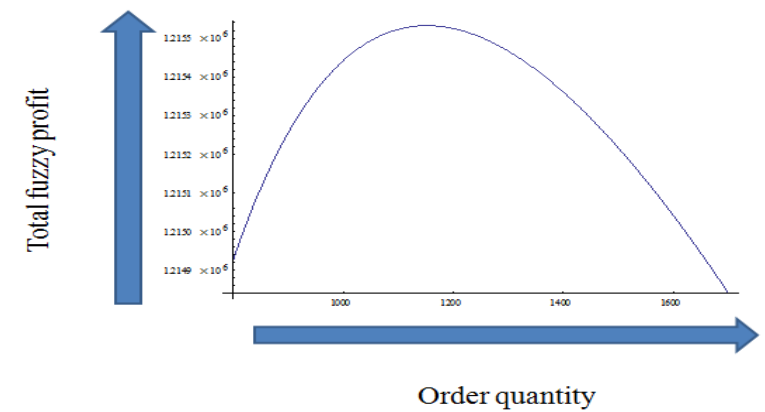
Figure 9. Concavity of total fuzzy profit for Scenario-3.